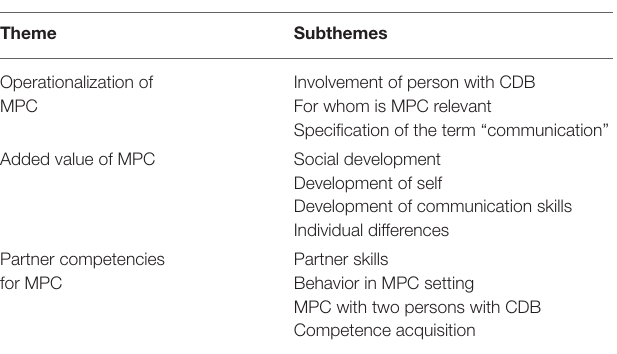
Involvement of person with CDB For whom is MPC relevant Specification of the term “communication” Development of self Development of communication skills Individual differences Partner skills Behavior in MPC